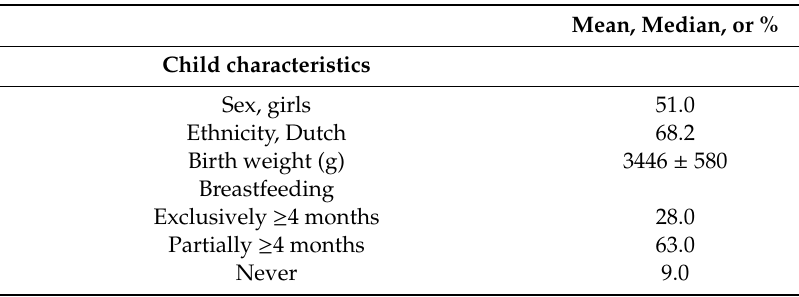
Table 1. Characteristics of the children and their mothers ( n =